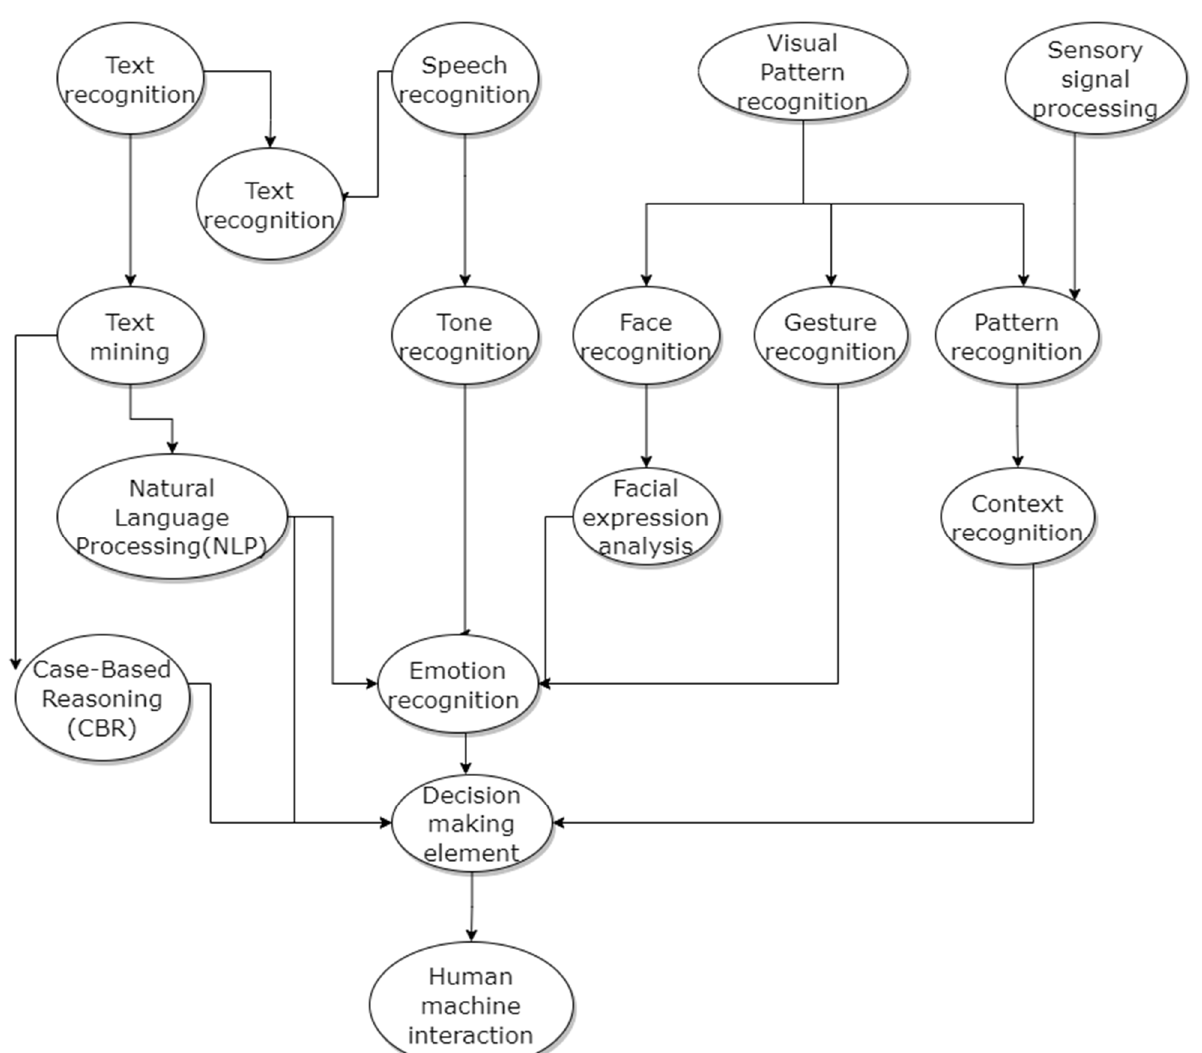
Figure 3. Capabilities evolution of the major AI specializations in conversational support service systems.